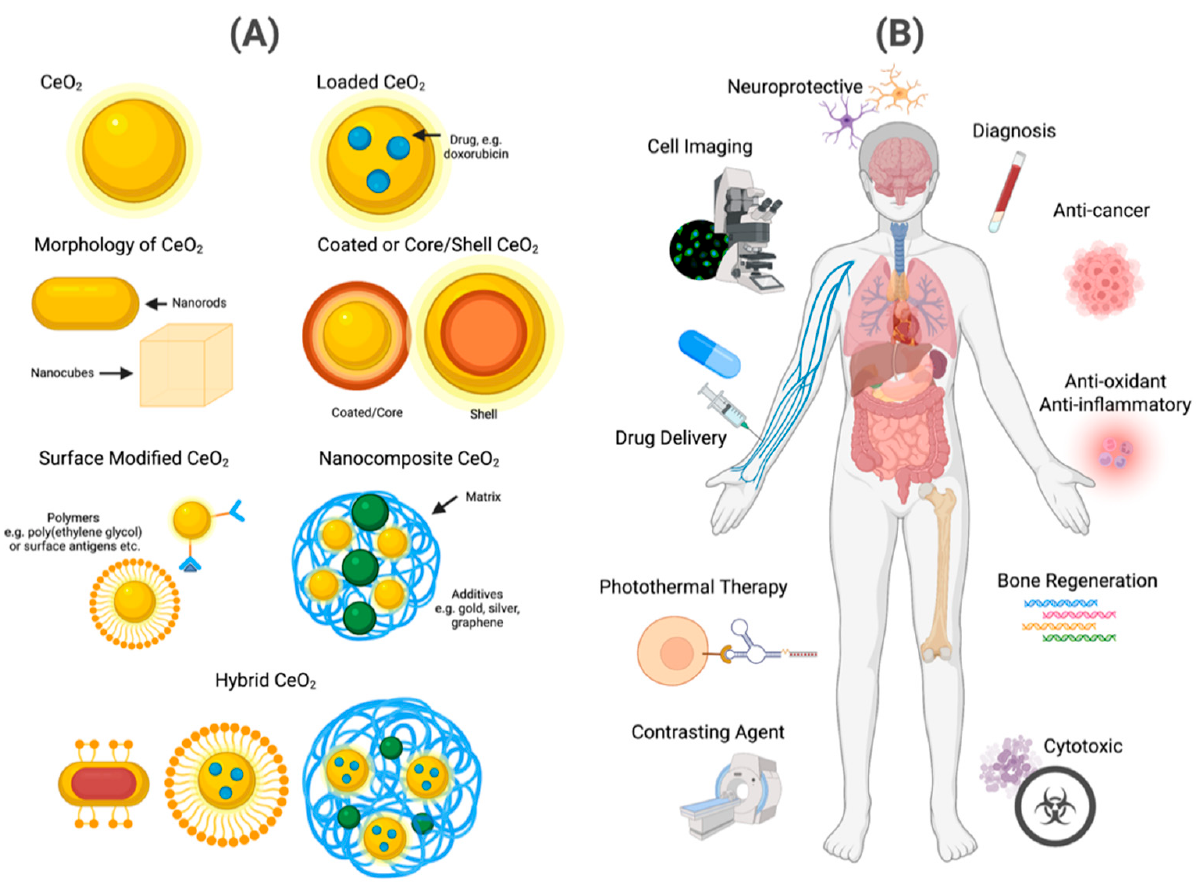
Figure 7. ( A ) Graphical representation of the various nanoparticle engineering manipula-tions of cerium oxide that have been implemented in ( B ) various biomedical applications (e.g., drug delivery agent, diagnosis, anti-cancer agent and contrasting agent).4. Materials and Methods.